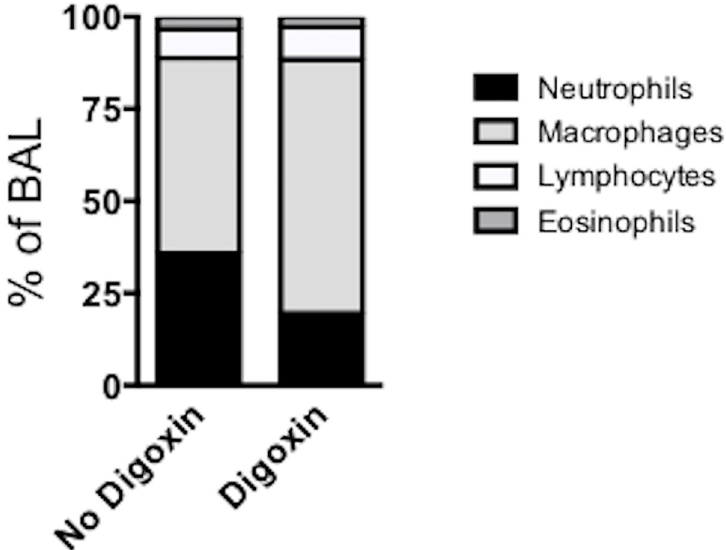
Fig 6. Altered leukocyte profiles in the BAL of digoxin treated calves. BAL samples were collected from all BRSV infected calves (with and without digoxin treatment) on day 10 post infection and cryopreserved in liquid nitrogen. Samples were thawed and the cell concentration was adjusted to 2x10 5 cells/mL. Cytopin preparations were made and cells were differentially stained with Modified Wright Stain. Numbers of neutrophils, macrophages, lymphocytes and eosinophils were determined by microscopy. Data are depicted as the mean relative frequencies of each population.